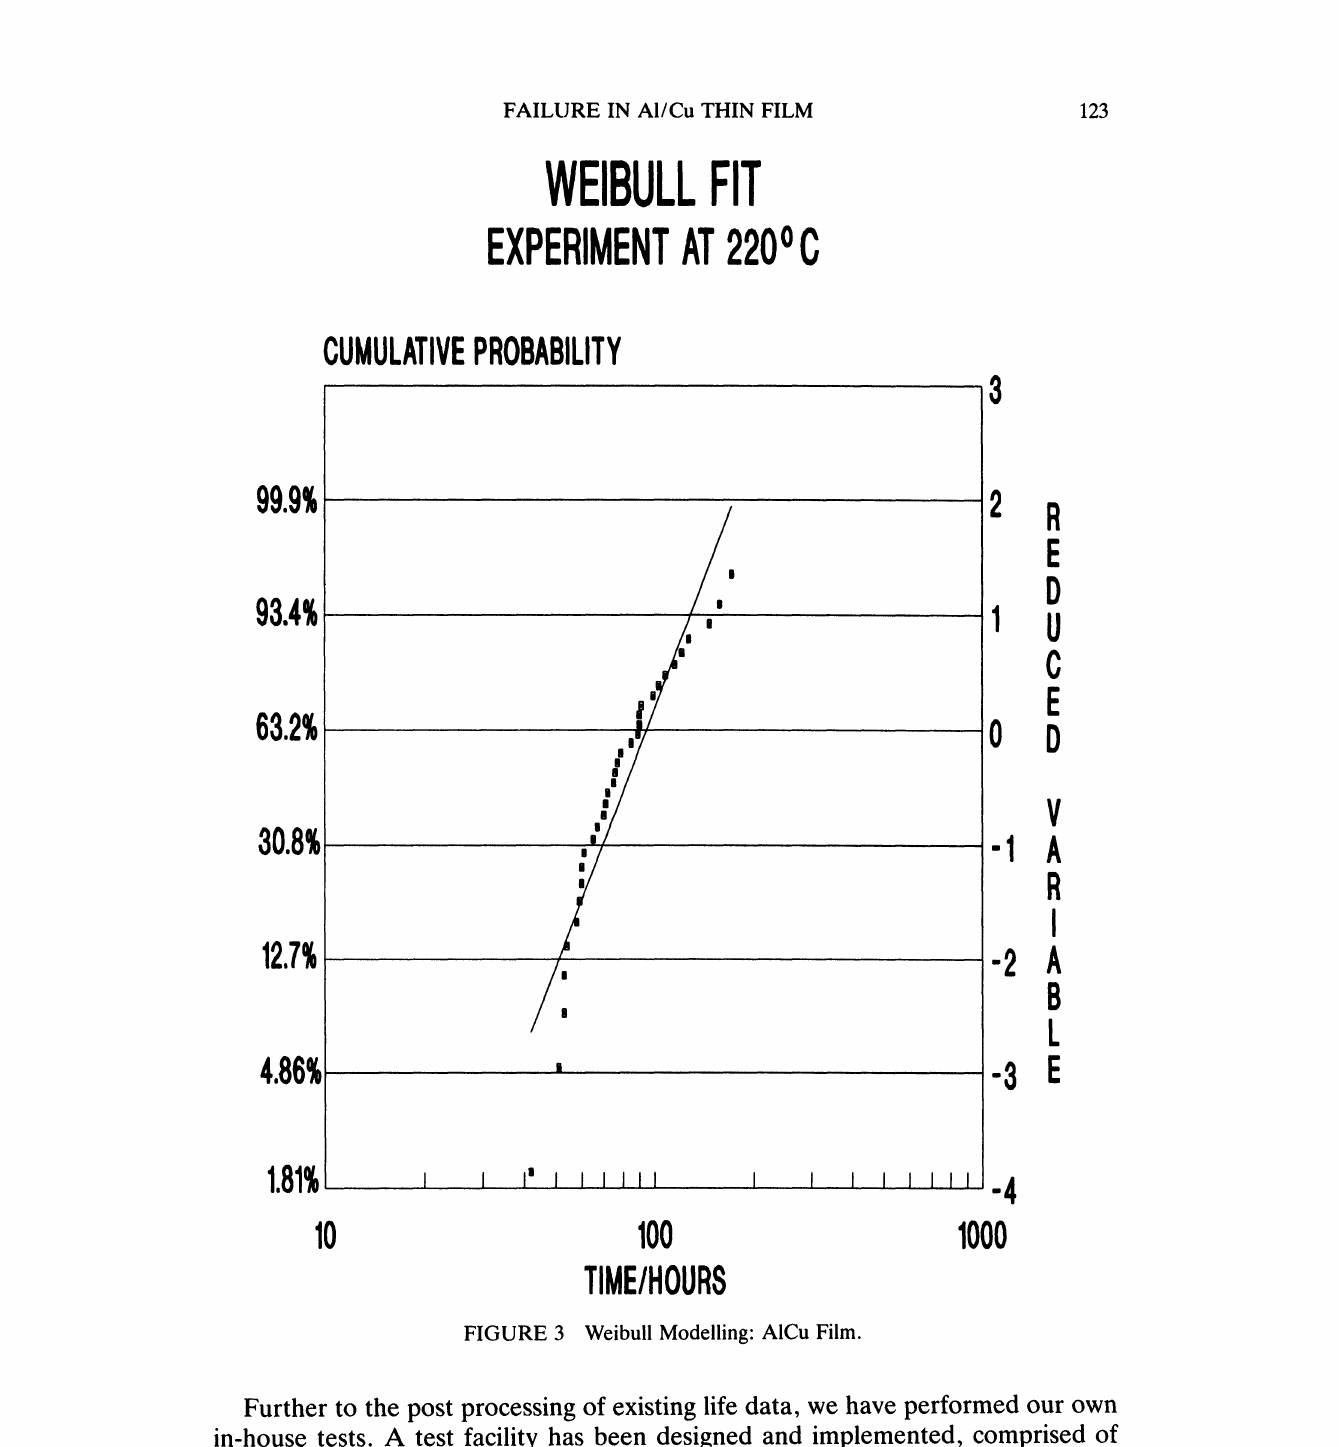
FIGURE 3 Weibull Modelling: AICu